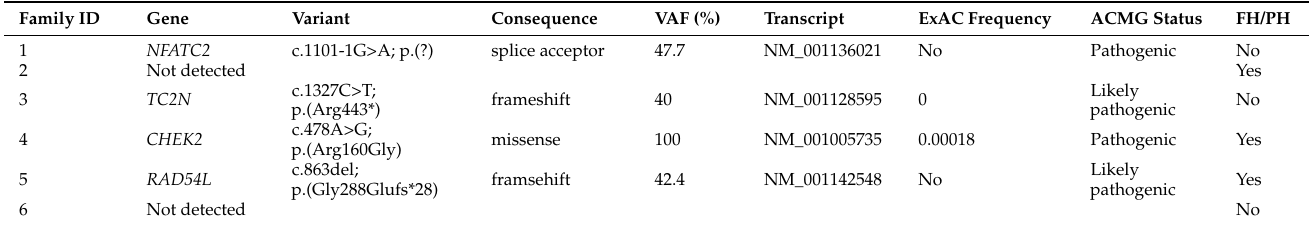
Table 2. Genes mutated in six families from Cohort